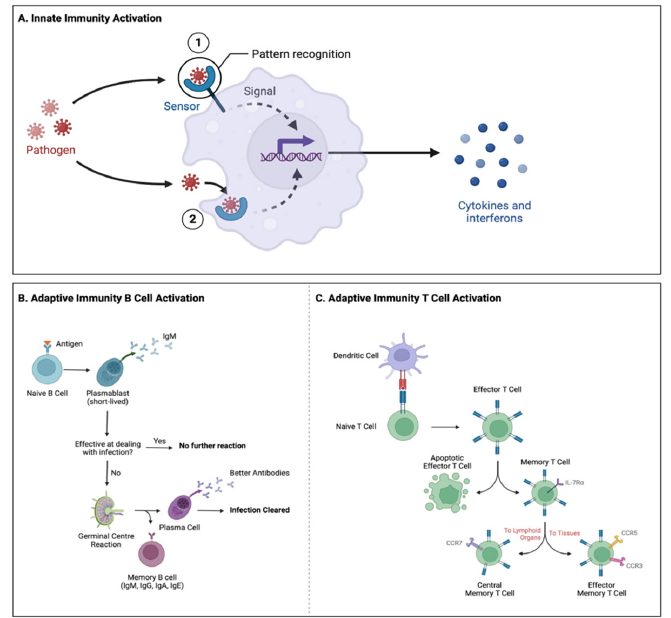
Figure 1. Innate and Adaptive Immunity Activation Process. ( A ) The innate immune system is the body’s first line of defense against foreign pathogens and consists of various types of cells such as monocytes, macrophages, neutrophils, mast cells, eosinophils, basophils, dendritic cells, and natural killer cells. The innate immune system is activated once pathogen-associated molecular patterns (PAMPs; i.e., LPS) or damage-associated molecular patterns (DAMPs; i.e., S100 proteins) are recog- nized by pattern recognition receptors (PRRs). PRRs have the ability to detect both (1) extracellular and (2) intracellular pathogens based on their cellular location. Once PRRs detect a pathogen they rapidly activate immune cells to produce cytokines and interferons to clear pathogens. The innate immune response can also clear pathogens through other processes such as destruction via phagocy- tosis, by natural killer cells and/or through the activation of the complement system. ( B ) The body’s second line of defense involves the adaptive immune system. Once exposed to a novel antigen, the antigen will bind to a B cell receptor (BCR) generated by V(D)J recombination which will result in the activation of the naïve B cell. Once activated, the naïve B cell will differentiate into antibody-secreting cells called plasmablasts. Immunoglobulin M (IgM) is the first antibody produced by plasmablasts to fight off the initial infection. If IgM is ineffective in fighting a pathogen, additional B cells will be generated through the germinal center as plasma cells and memory B cells. The B cells have optimized BCRs better equipped to fight off pathogens. Plasma cells can secrete antibodies for weeks following their activation and then migrate to the bone marrow where they can reside for long periods of time. Memory B cells circulate throughout the body on the lookout for antigens that bind to their BCR and quickly respond to remove the antigen if encountered. With every subsequent pathogen encounter, this cycle will repeat to further optimize the BCRs. ( C ) As part of the adaptive immune response, T cells can become activated through dendritic cells and other antigen presenting cells. Dendritic cells contain novel antigens from peripheral tissue which are presented to T cells for activation of the cell. Once activated, naïve T cells differentiate into effector T cells which can either directly induce apoptosis in an infected cell (i.e., cytotoxic T cell), activate other immune cells (i.e., helper T cell), or suppress an immune response (i.e., regulatory T cell). Once antigens have been cleared, effector T cells can further differentiate into memory T cells which are antigen-specific T cells. Memory T cells can then differentiate to central memory T cells and effector memory T cells. Effector memory T cells primarily localize in peripheral tissue and provide an immediate defense against reintroduced antigens while central memory T cells reside in secondary lymphoid tissues and sustain the im- mune response against the specific antigen ( A ) adapted from “Innate Immunity”, by Biorender.com (accessed on 16 October 2022). Retrieved from https://app.biorender.com/biorender-templates (accessed on 16 October 2022), ( B , C ) created with Biorender.com (accessed on 16 October